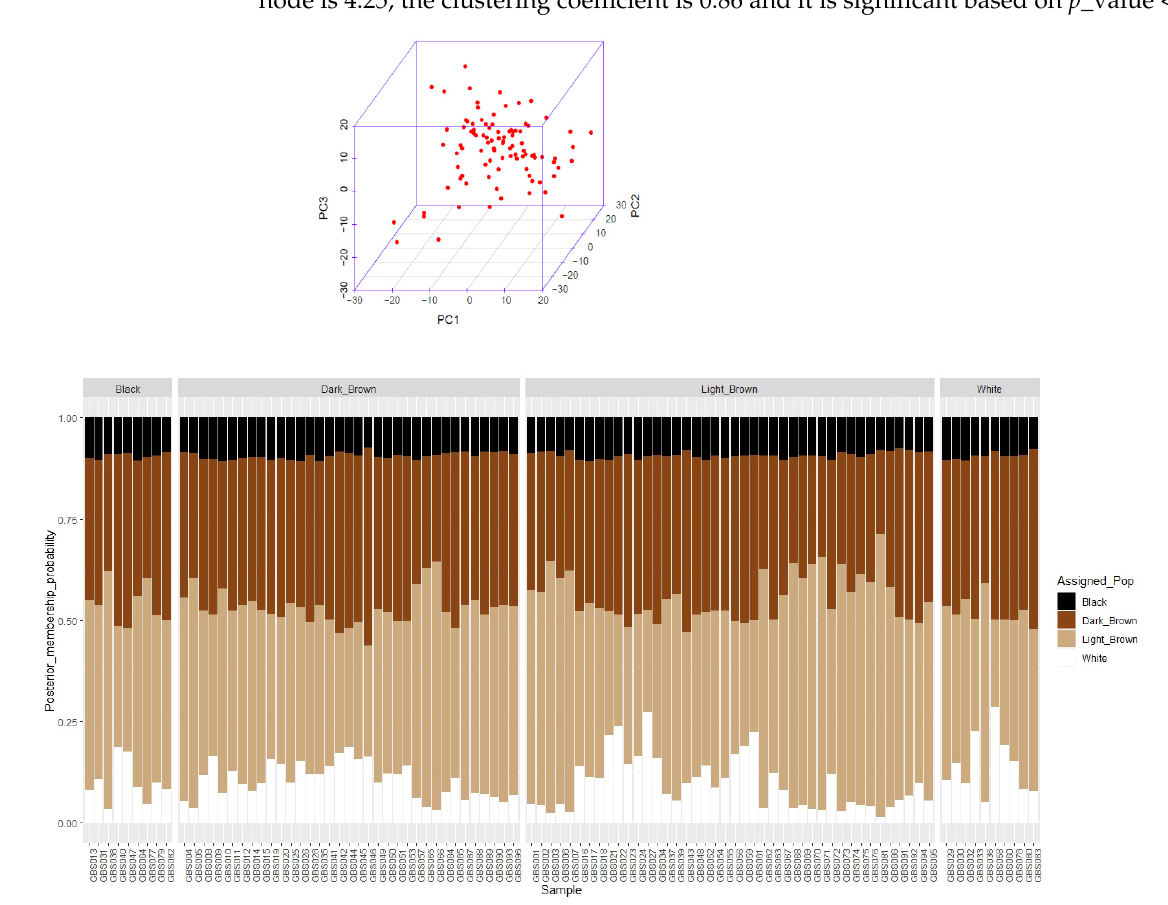
Figure 1. Principal component analysis of 96 dromedary camels of Iran central desert using 14,522 SNPs in five regions in above figure ( A ). Admixture of 96 dromedary camels among four coat colors: light-brown, dark-brown, black, and white, where the x-axis shows sample number and the y-axis show the probability of each camel belongs to coat color (color = K) in bottom figure ( B ).